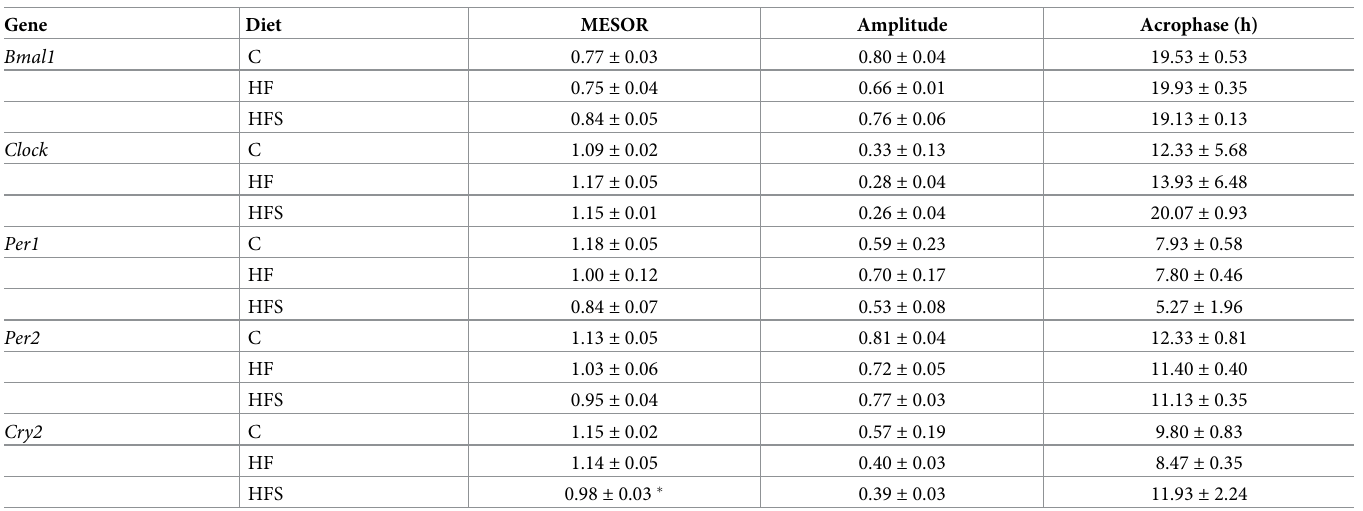
Table 3. Cosinor analysis of peripheral circadian genes.